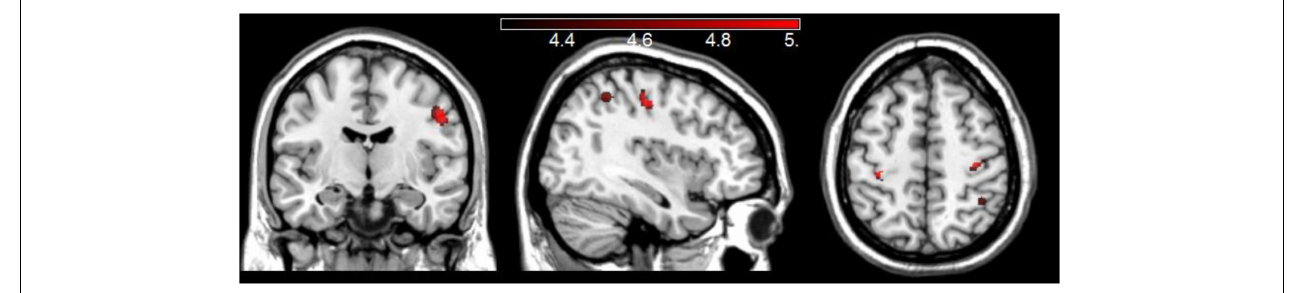
FIGURE 2 | Areas with more GM in YA compared to OA when considering the groups’ proverbs scores and adjusting for sex and